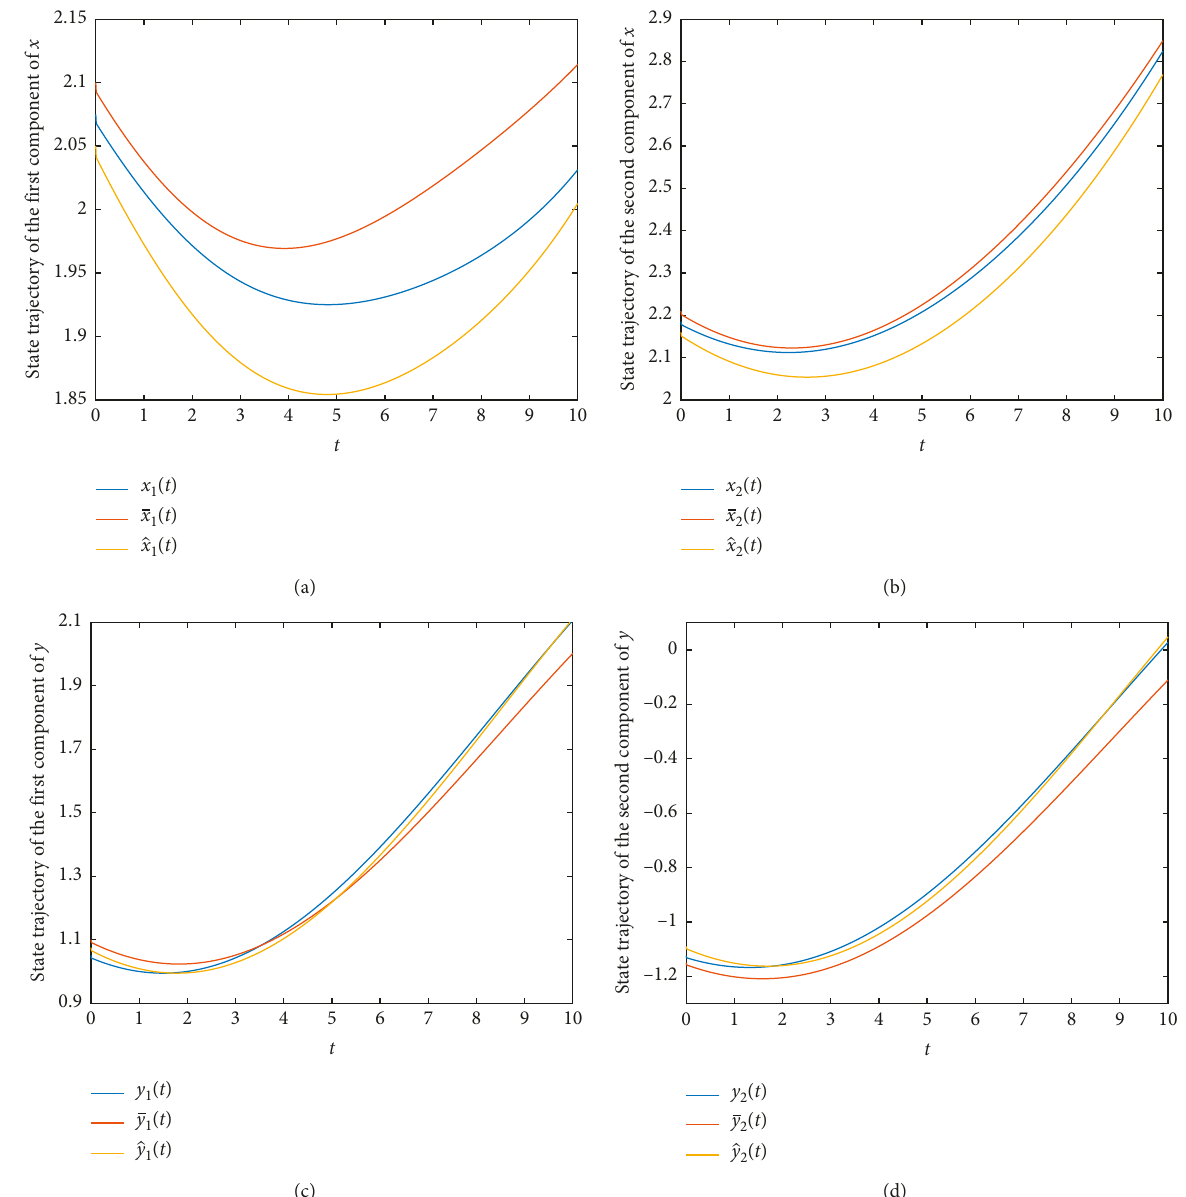
Figure 5: State trajectories of the system for three initial conditions in Example